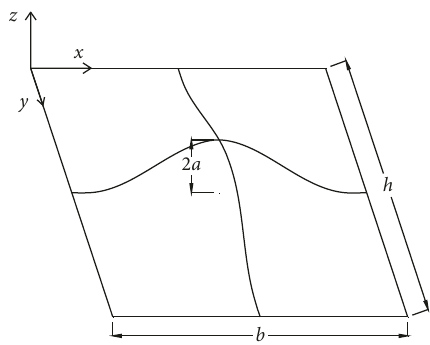
Figure 10: Simplified calculation model for the buckling area.